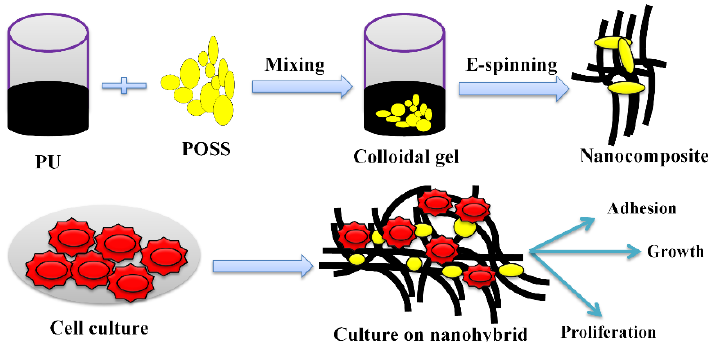
Figure 7. Microscopic metaphors of ( a ) growing myoblasts on POSS-grafted PU nanomatrix. Dashed bright yellow arrows point to POSS molecules, whereas solid arrows indicate spreading of myoblasts ( b ) confluent growth of C2C12 cells just prior to differentiation ( c ) Giemsa tinge depic- tion of myotube creation with prominent nuclei (dashed yellow arrows) during differentiation in petite quantity of serum. Bar graph illustration of ( d ) OD (600 nm) of spent culture supplemented